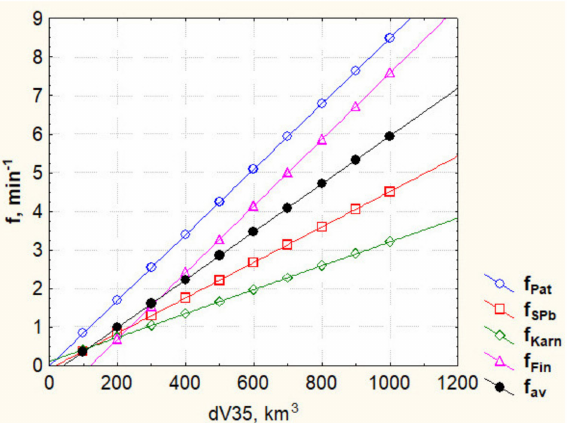
Figure 5. Linear approximations between the LF strikes frequency f (min − 1 ) and supercooled volume dV35 ( f av —averaged frequency). Abbreviations are as indicated in Table 2; f av is the mean relationship for all four cloud